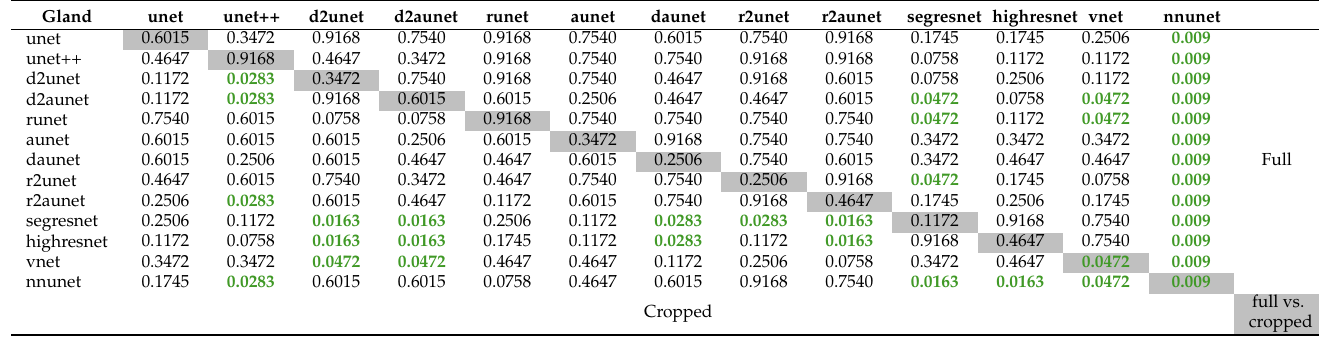
full vs. cropped